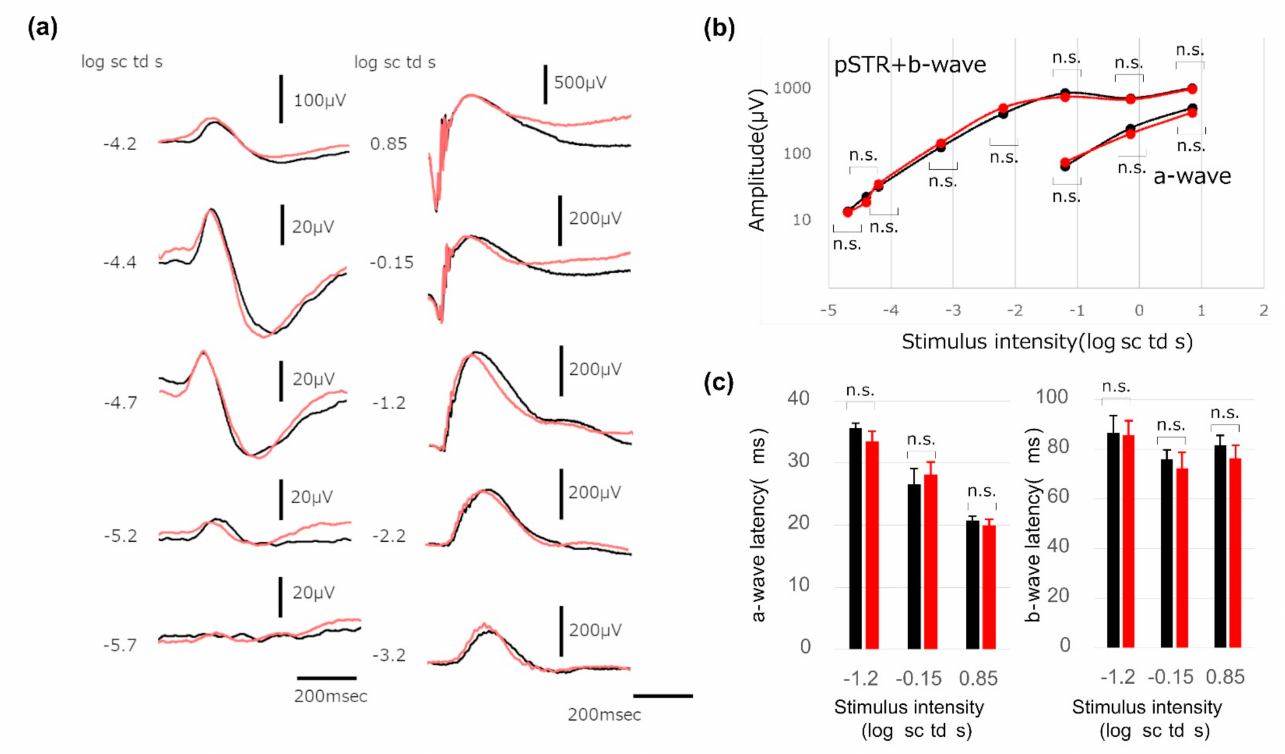
Figure 7. Results of scotopic electroretinography (ERG) phenotype. ( a ) Representative dark-adapted ERG recordings. ( b ) Quantitative analyses of the amplitude of pSTR + b-wave ( n = 6). ( c ) Quantitative analyses of the latency of a- and b-waves ( n = 6). Error bar = standard deviation. Black lines or black bars represent the data from aged (45 weeks old) WT mice and red lines or red bars represent the data from aged (45 weeks old) Mrp4 -null mice. pSTR, positive scotopic threshold response; n.s., not